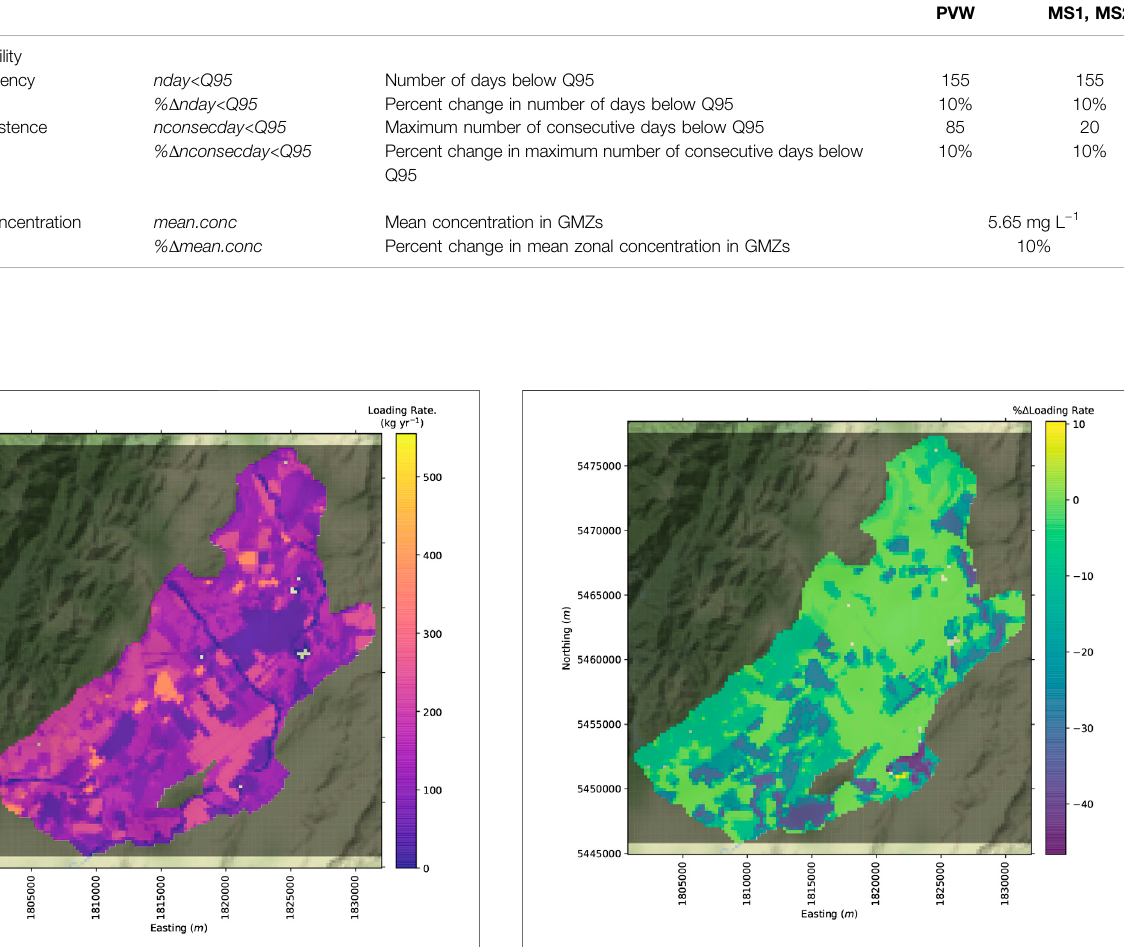
FIGURE 4 | Percentage change in nitrate loading rate from